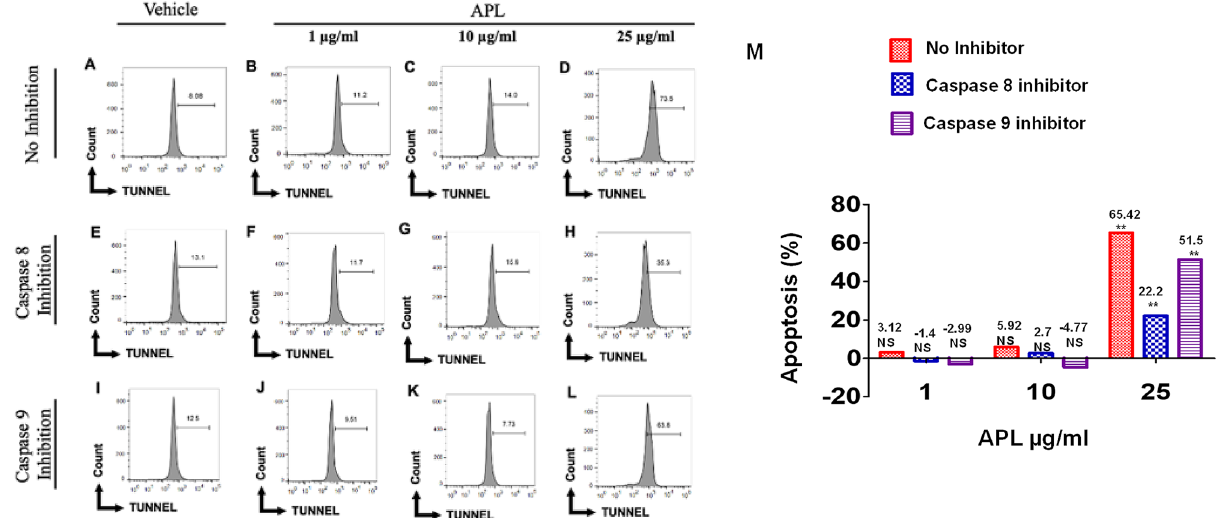
Figure 6. Role of caspase 8 and 9 in apoptosis induction in EL4 cells: This was determined by TUNNEL assay. Cells were treated at different concentrations with APL ( Psiadia lithospermifolia ) and vehicle or in the presence of inhibitors of caspase 8 and 9. ( A – D ) represent treatment without any inhibitors of caspases where ( A ) (vehicle DMSO), ( B ) (1 µg/ml), ( C ) (10 µg/ml), ( D ) (25 µg/ml) of APL. ( E – H ) Represent treatment with APL in presence of caspase 8 inhibitor. ( E ) (vehicle DMSO), ( F ) (1 µg/ml), ( G ) (10 µg/ml), ( H ) (25 µg/ml) of APL extract. ( I – L ) represent treatment with APL in presence of caspase 9 inhibitor. ( I ) (vehicle DMSO), ( J ) (1 µg/